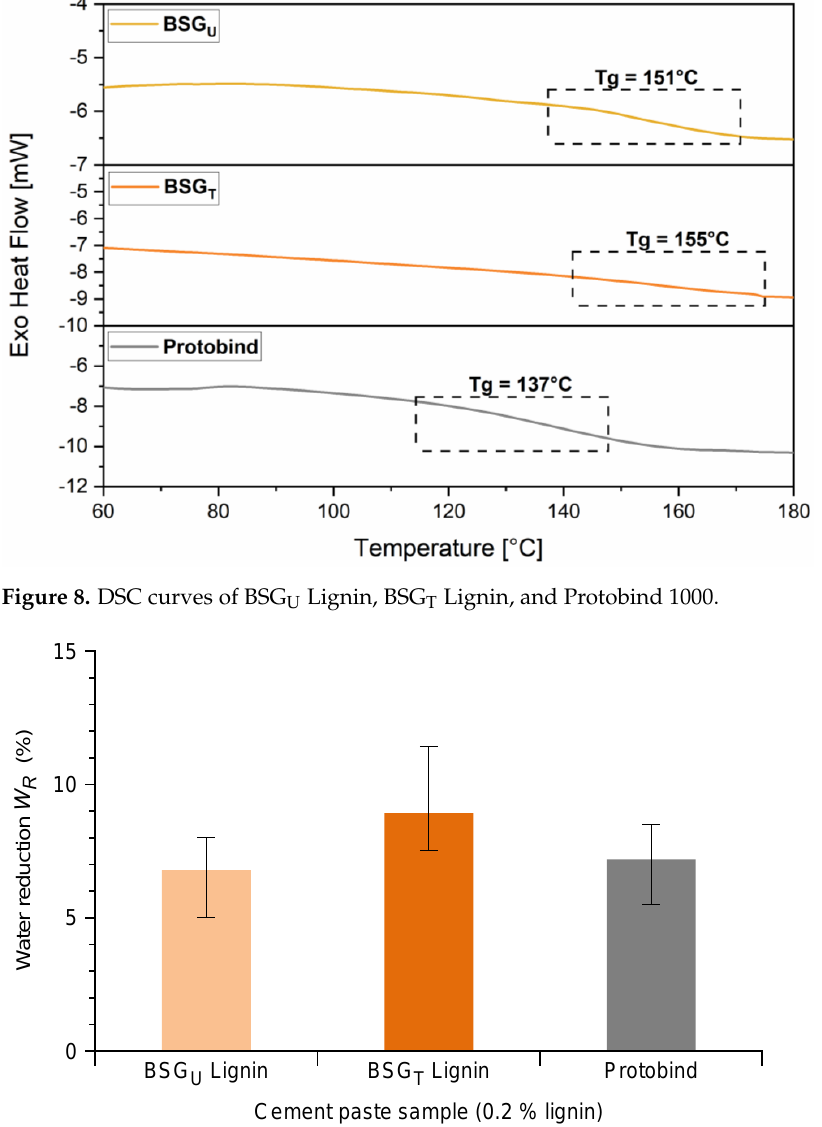
Figure 9. Measured water reduction capability for cement pastes containing 0.2% BSG U Lignin, BSG T Lignin, and Protobind. Error bars show confidence interval (95%) of the inverse linear regression.